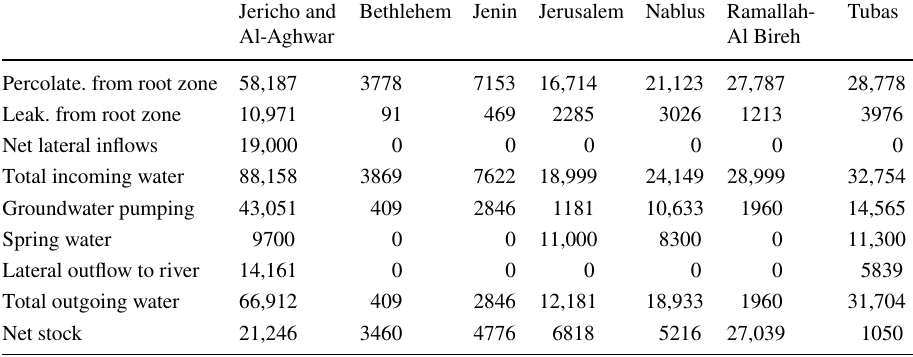
balances for West Bank districts in the JRB: incoming